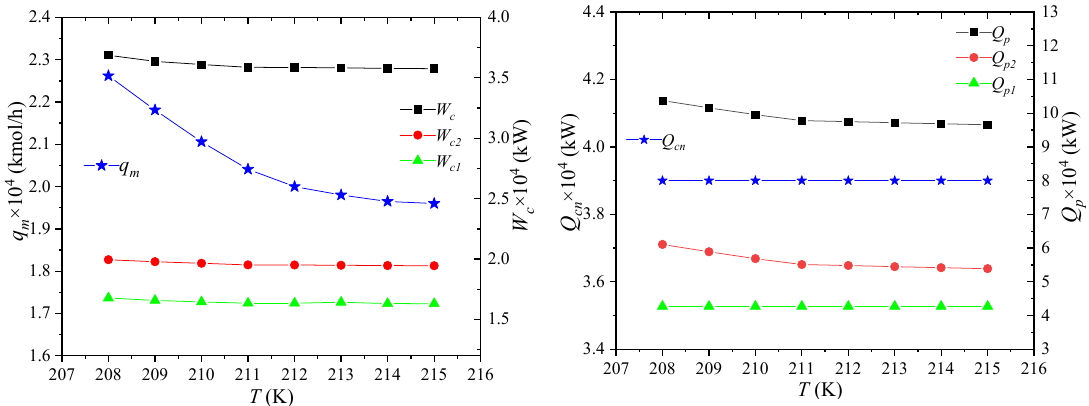
Figure 9. Effects of low-pressure mixed refrigerant temperature on process performance. Figure 9. E ff ects of low-pressure mixed refrigerant temperature on process performance.